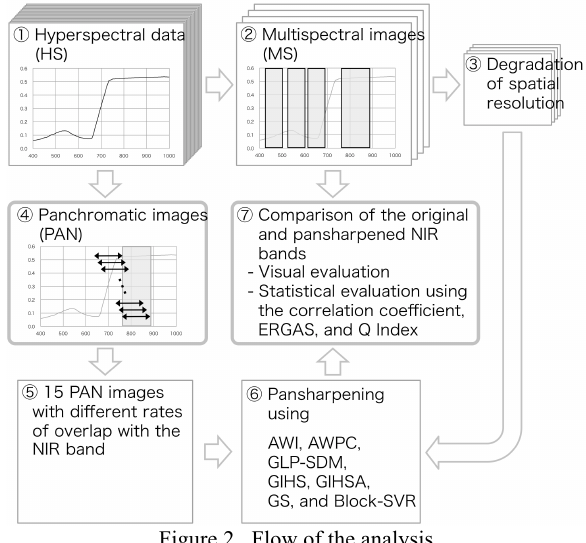
Figure 2. Flow of the